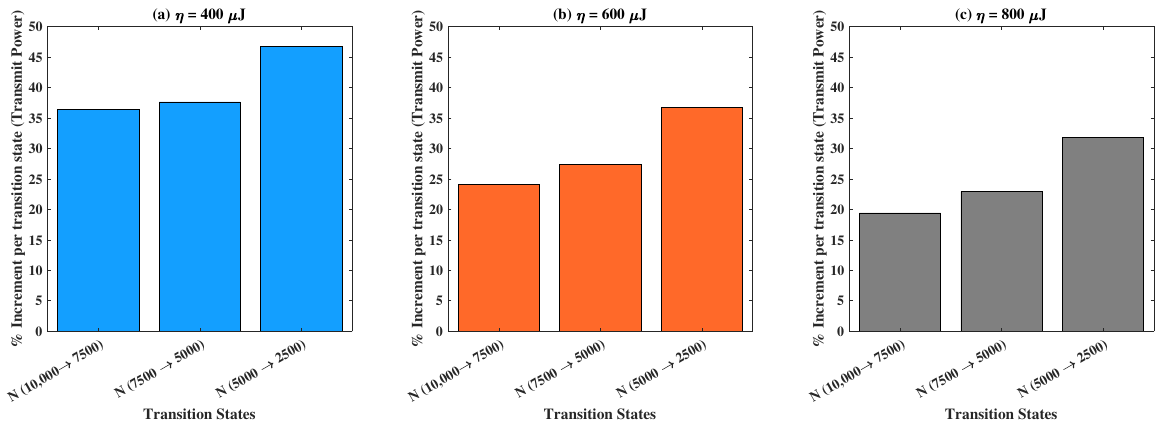
Figure 5. Percentage increment in transmit power versus different transition states pertaining to N for: ( a ) η = 400 µ J, ( b ) η = 600 µ J, and ( c ) η = 800 µ J.